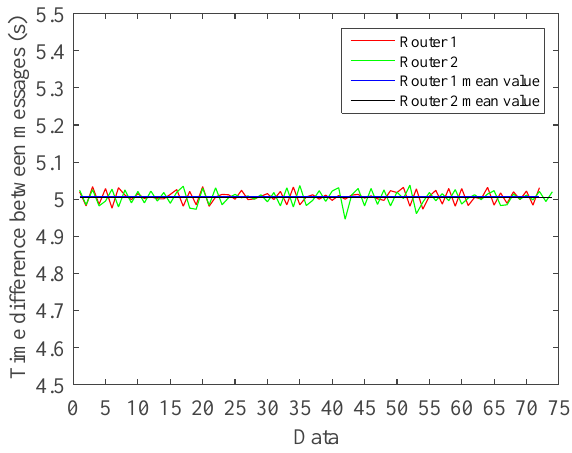
Figure 15. Case A.1: Time intervals between the data points received.